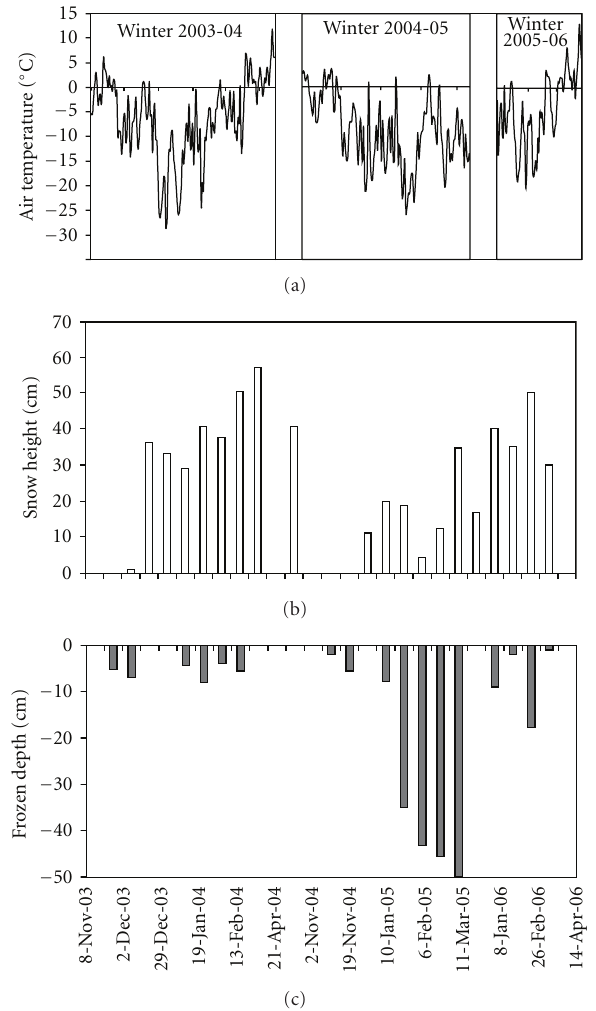
Figure 3: Temporal variation for: (a) air temperature, (b) snow height, and (c) frozen depth (0–50cm depth).